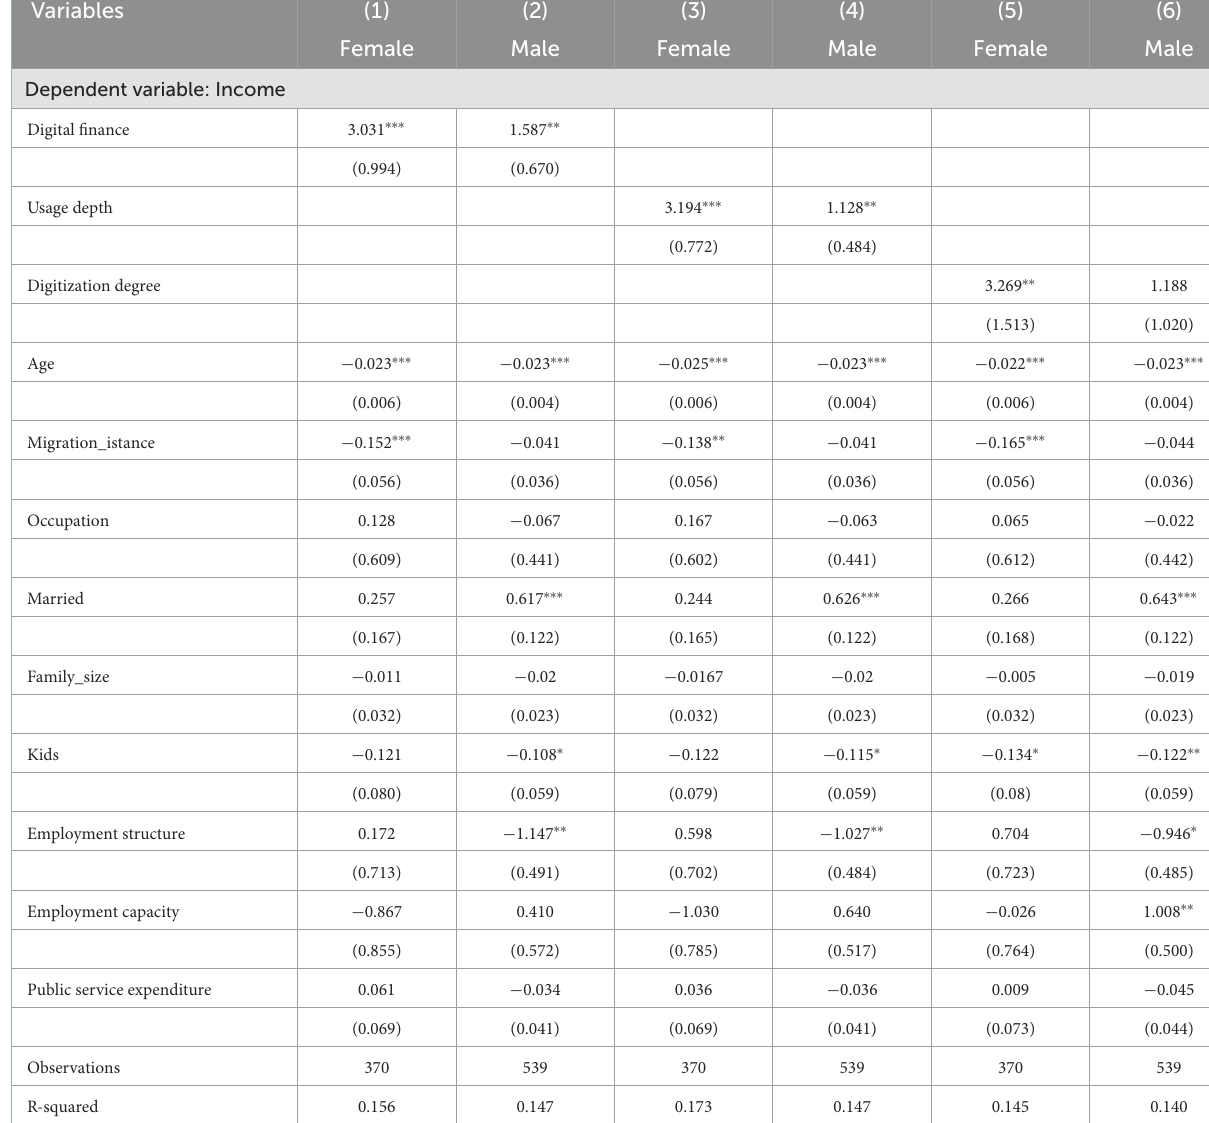
TABLE 8 Results of the effect of digital finance on migrant workers’ urban integration (mediation effect of their income).